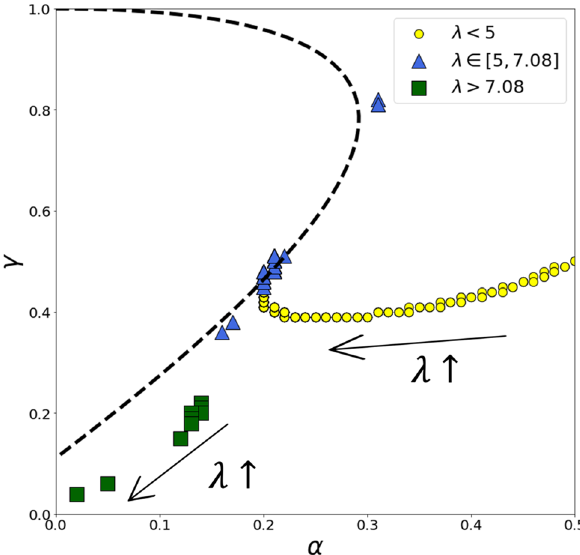
Figure 3. QRE for PD in Markov using solving optimization problem (18) for different values of rationality. The arrows indicate the directional growth of rationality. The resulting QRE curve contains three branches that correspond to various ranges of rationality. The dashed line represents the Nash